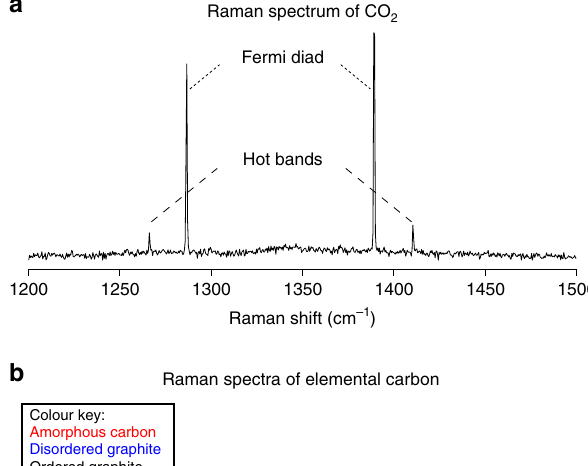
after MI entrapment 47,48 , the observed distribution of volatile species between glass and bubbles within MIs suggests the dominant occurrence of gas exsolution and bubble formation at relatively high pressures from a CO 2 -rich melt.